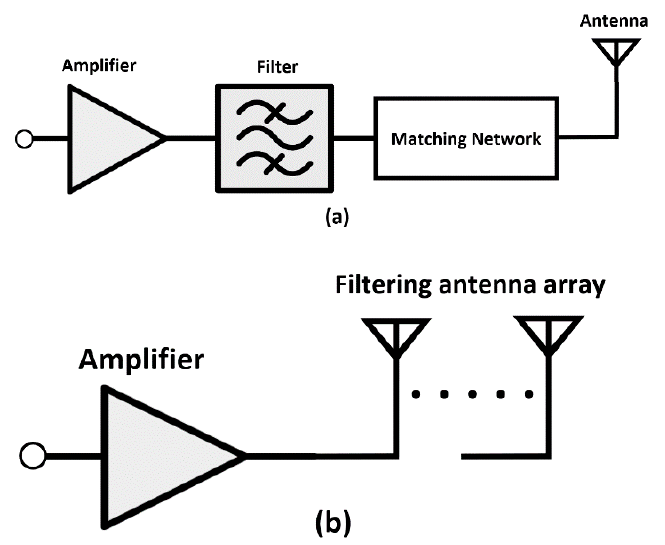
Figure 1. RF front-end architecture ( a ) Traditional design approach; ( b ) Proposed design approach.